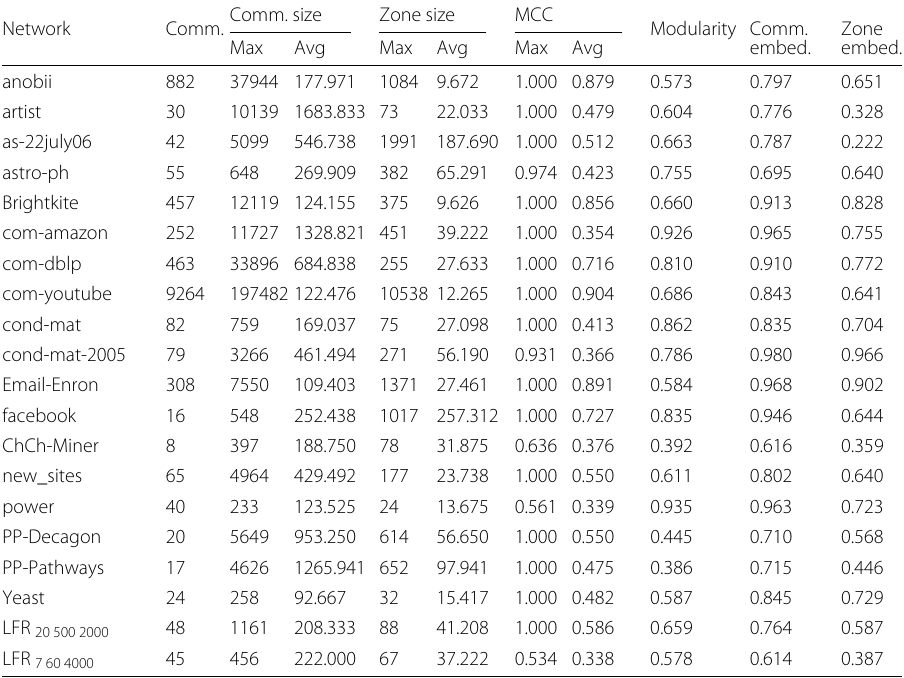
Table 16 Match of zones and communities detected by Louvain algorithm